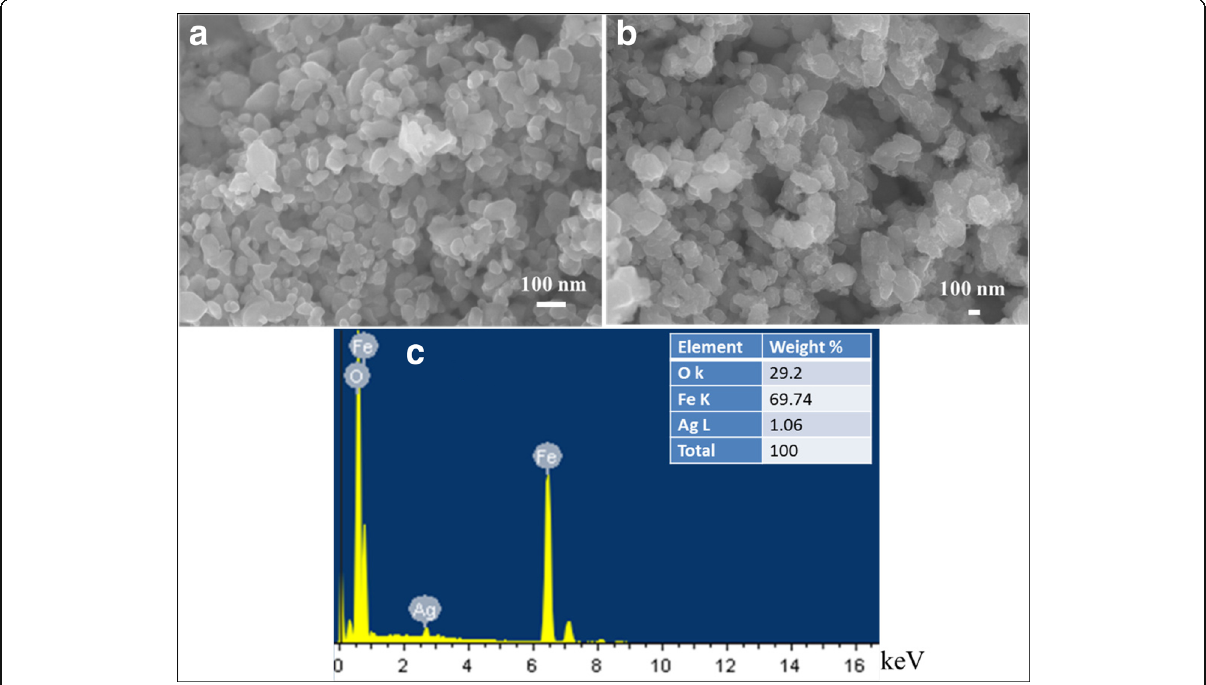
Fig. 4 SEM images of a α − Fe 2 O 3 , b 1%Ag/ α − Fe 2 O 3 , and c EDS analysis of 1%Ag/ α − Fe 2 O 3